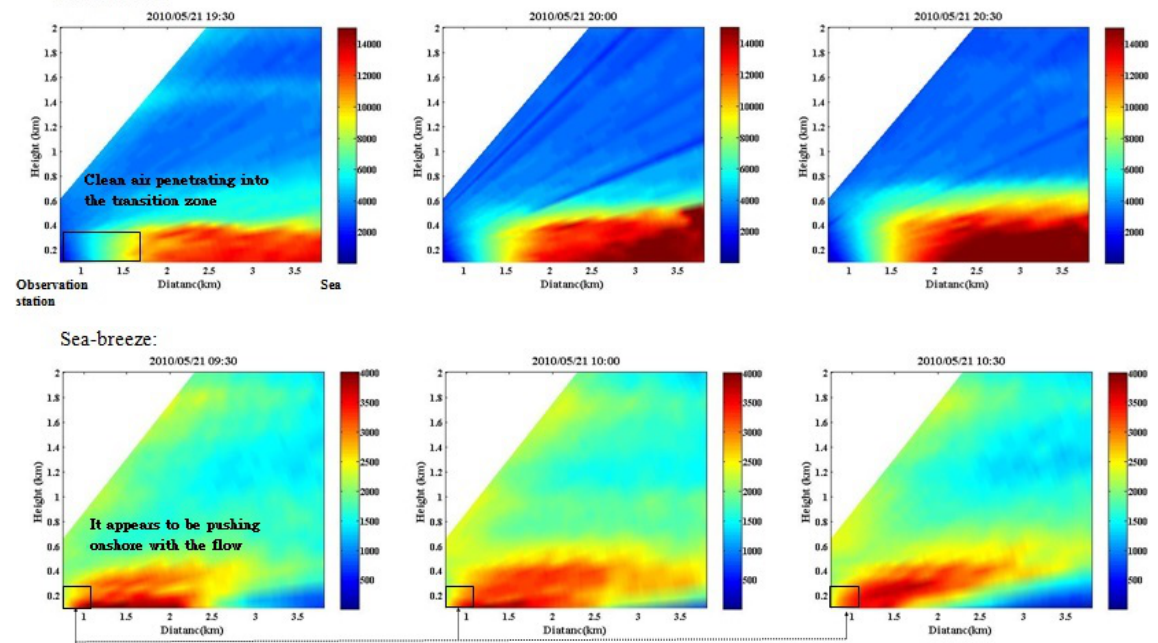
Figure 8. Range height indicator (RHI) plot of lidar backscattered signal at 532nm of land (top panels) and sea (bottom panels) breeze cases. The lidar measurements were taken at NCU, Chung-Li, on 21 May 2010.